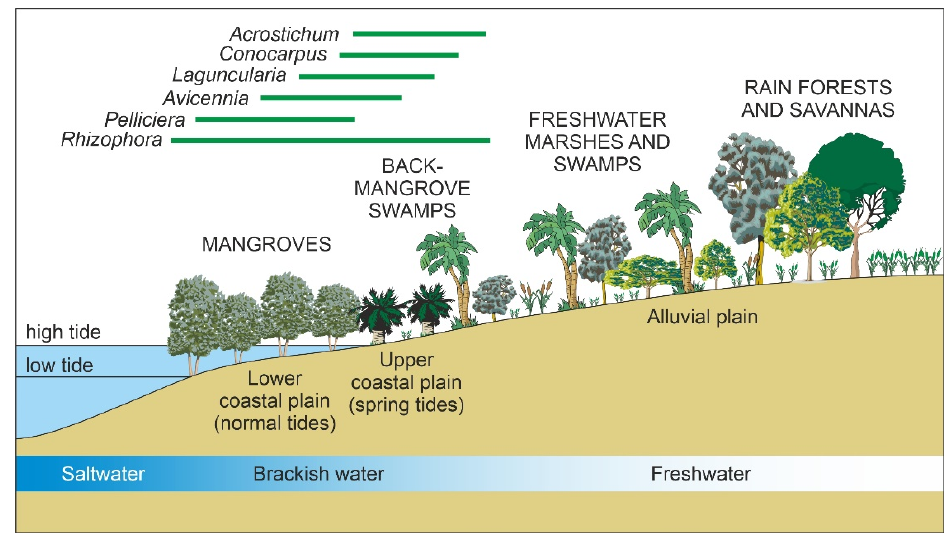
Figure 8. Idealized transect showing the typical coastal zonation of Caribbean mangroves. The approximate ranges of the most important mangrove elements are indicated by green lines. Modified from Ref. [20].